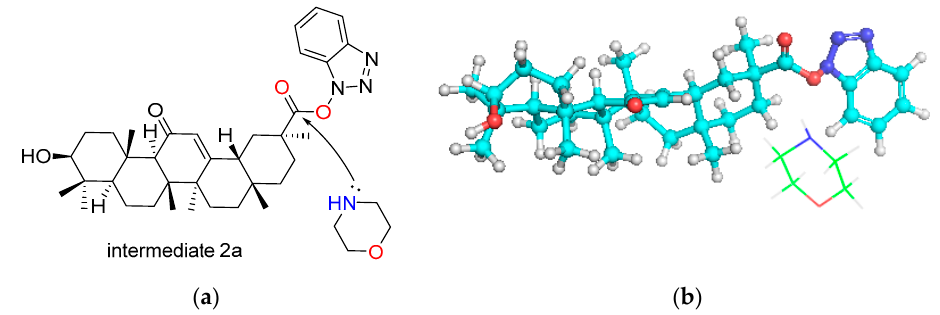
Figure 2. ( a ) The proposed mechanism of amidation reaction. Energy minimization by MM2 was performed using ChemBio3D Ultra 14.0 (CambridgeSoft Corporation, 2014) software force field. ( b ) The picture of 3D structure was produced using PyMOL (Delano Scientific, USA).